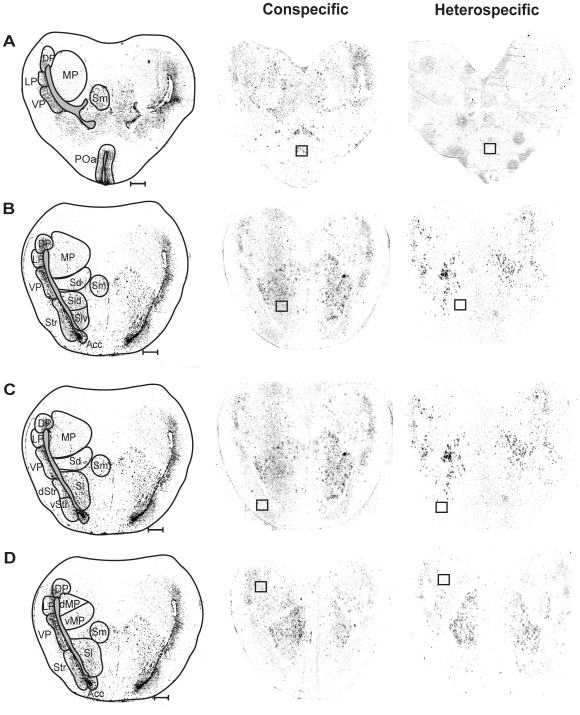
Brightfield images (left column) and inverted darkfield images of transverse sections showing egr-1 expression within sampling windows (boxes) in response to conspecific whine-chucks (middle column) and heterospecific whines (right column) in the anterior preoptic nucleus (A), septum (B), striatum (C), and medial pallium (D).Scale bars represent 400 µm. Abbreviations: Acc, nucleus accumbens; dMP, dorsal part of the medial pallium; DP, dorsal pallium; dStr, dorsal striatum; LP, lateral pallium; MP, medial pallium; POa, anterior preoptic nucleus; Sd, dorsal septal nucleus; Sl, lateral septal nucleus, Sld, dorsolateral septal nucleus; Slv, ventrolateral septal nucleus; Sm, medial septal nucleus; Str, striatum; vMP, ventral part of the medial pallium; VP, ventral pallium; vStr, ventral striatum.